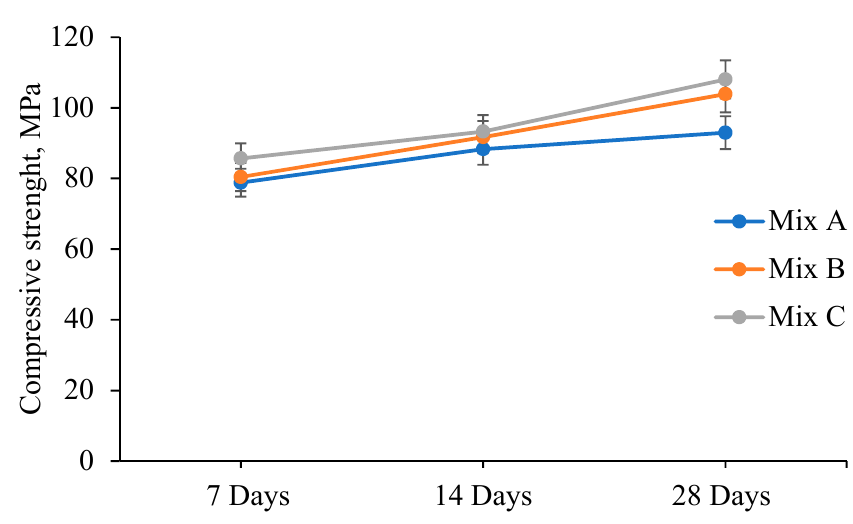
Figure 6. Trial mix of the compressive strength results.